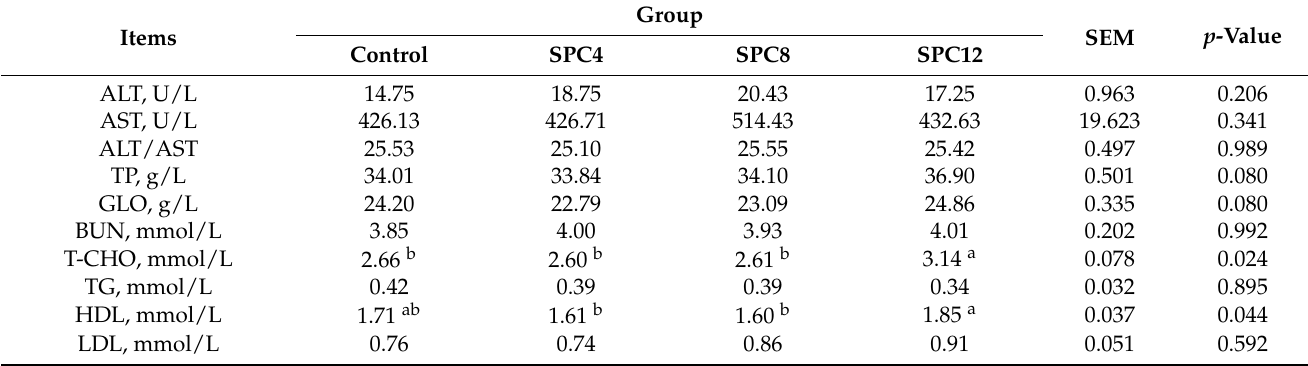
Table 5. Effects of dietary SPC on Blood Biochemical Parameters of broilers at 42 d.